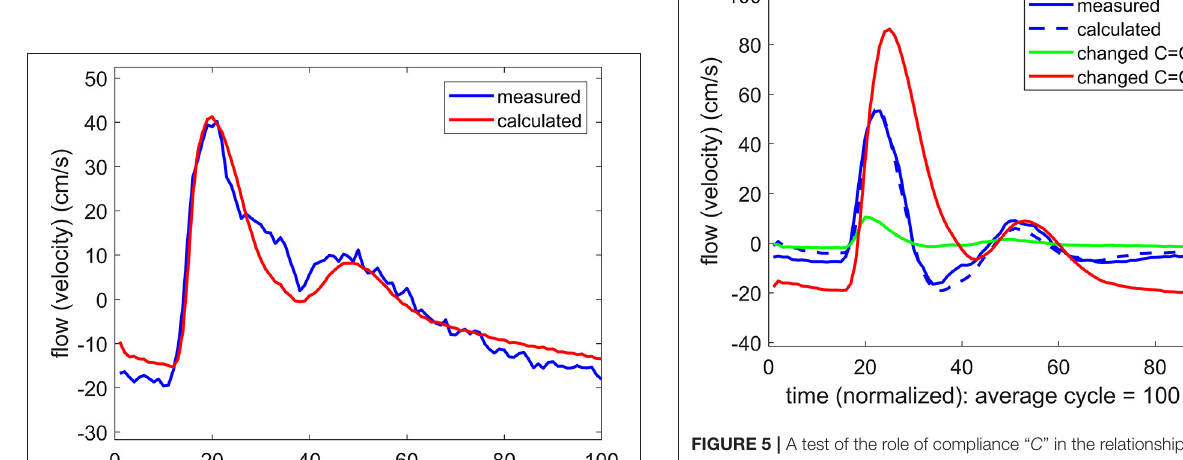
Frontiers in Physiology |